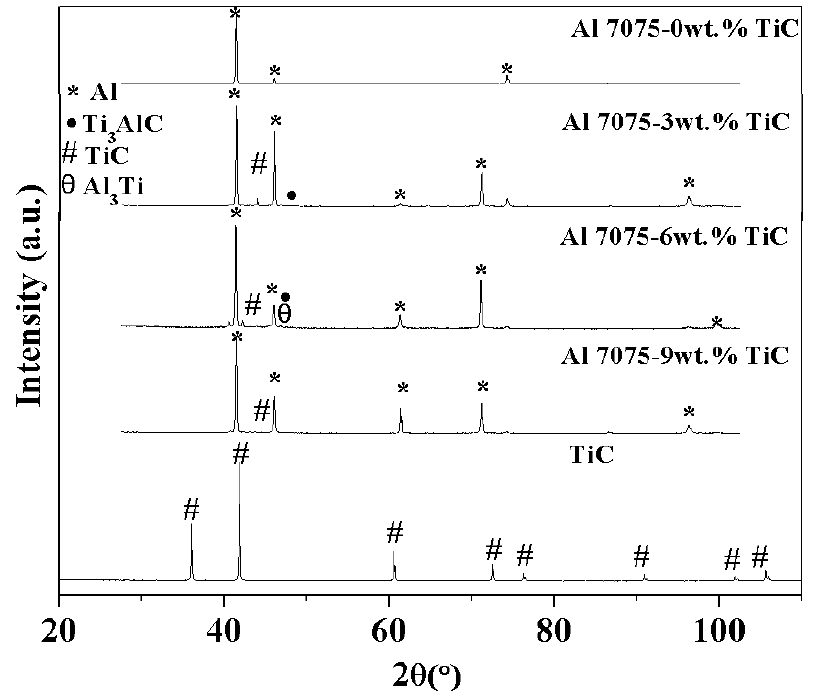
Fig. 6. XRD patterns of TiC, Al 7075 alloy and the composites with different weight percent of